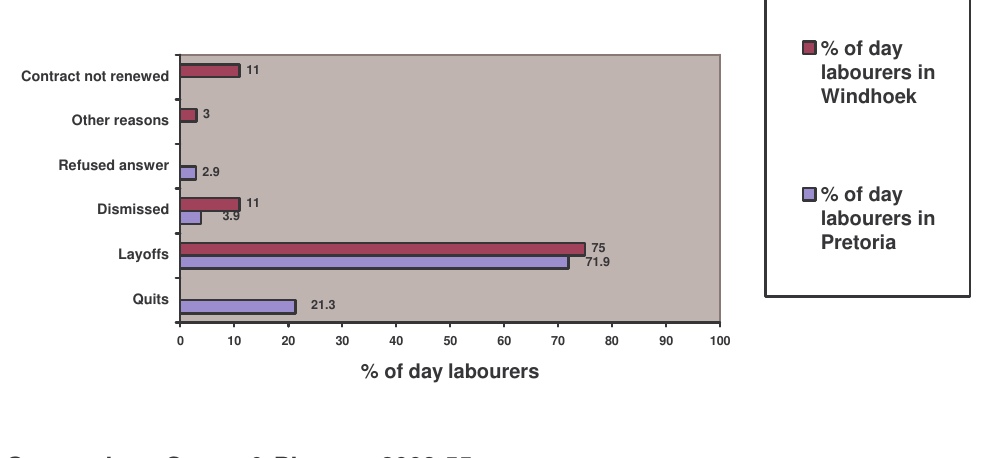
Figure 4: Reasons for terminating previous formal sector employment by day labourers in Pretoria (2004) and Windhoek